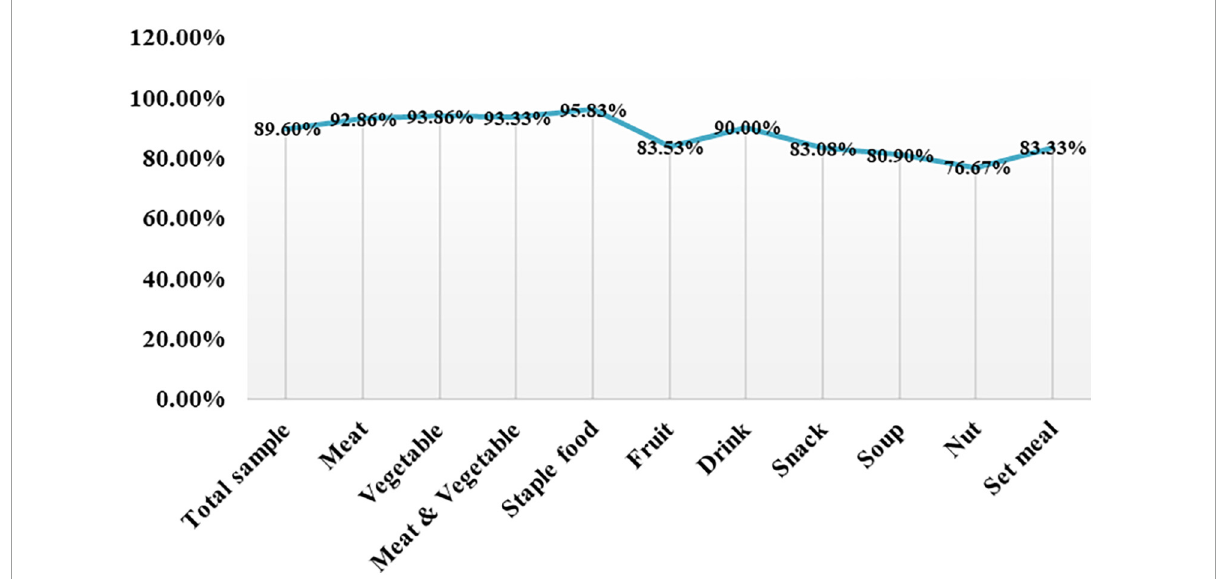
FIGURE5 Recognition accuracy rates of the Aliyun Cloud Food Recognition API for different food classifications.